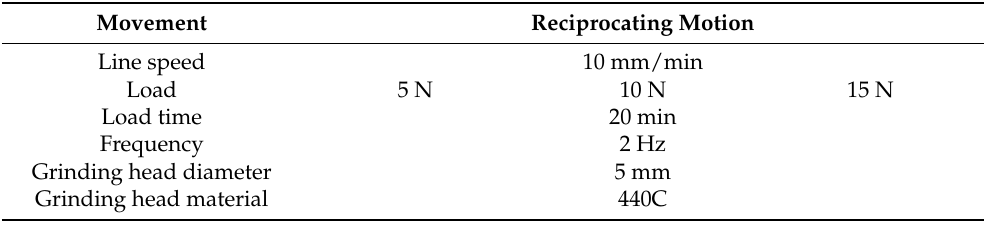
Figure 4. Cold spray process of Al–basalt fiber hybrid. Through this experiment, 15 vol.% and 30 vol.% basalt-reinforced composite coatings were successfully prepared on Al substrate under the conditions of 5 MPa and 380 °C by the PCS1000 equipment. To investigate the wear resistance of the composite coating, the friction-wear test was performed on composite coatings with basalt contents of 15 vol.% and 30 vol.%. The relevant experimental data are shown in Table 4. Table 4. Experimental friction and wear parameters.